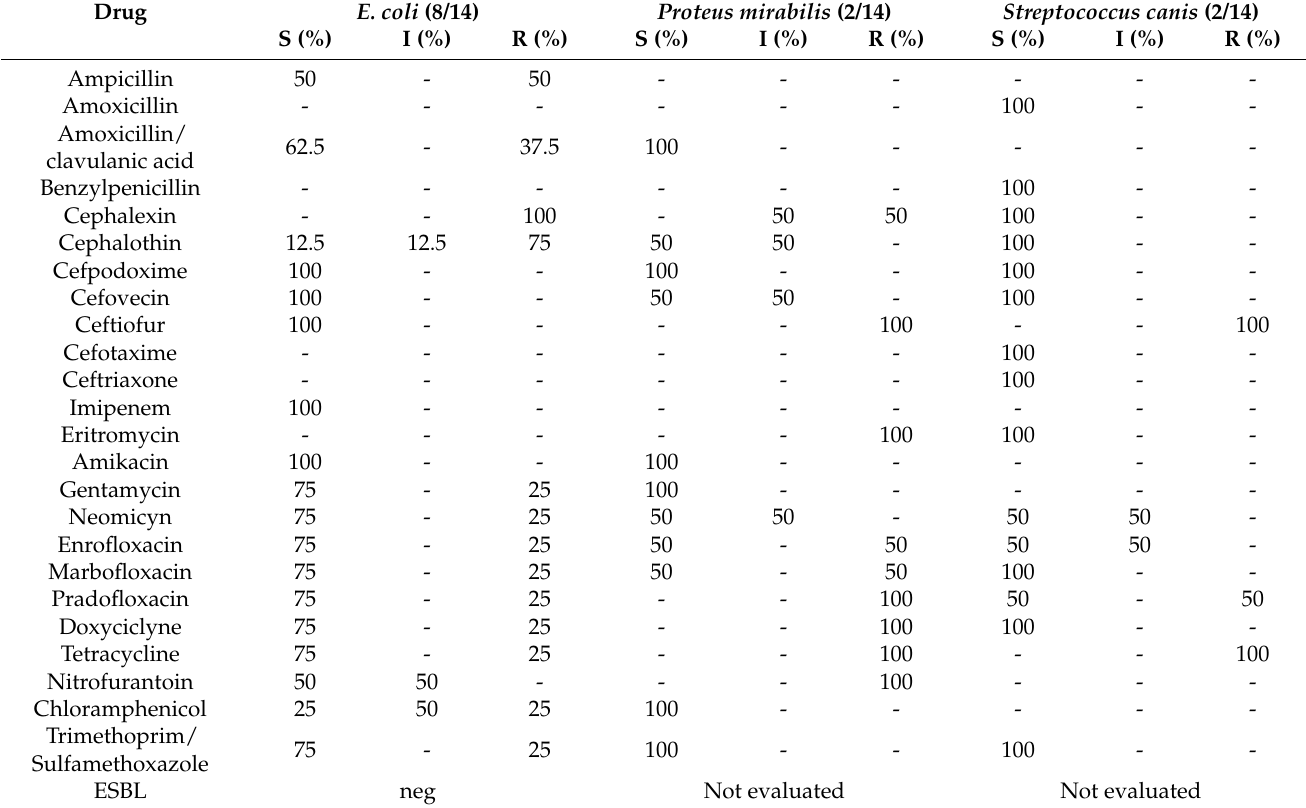
Table 1. Table summarizes most representative bacteria isolated from urine samples in dogs ( n = 14). Legend: S = sensitive, I = intermediate, R = resistant. Bacteria were ranked according to minimal inhibitory concentration (MIC) values presented in CLSI guidelines